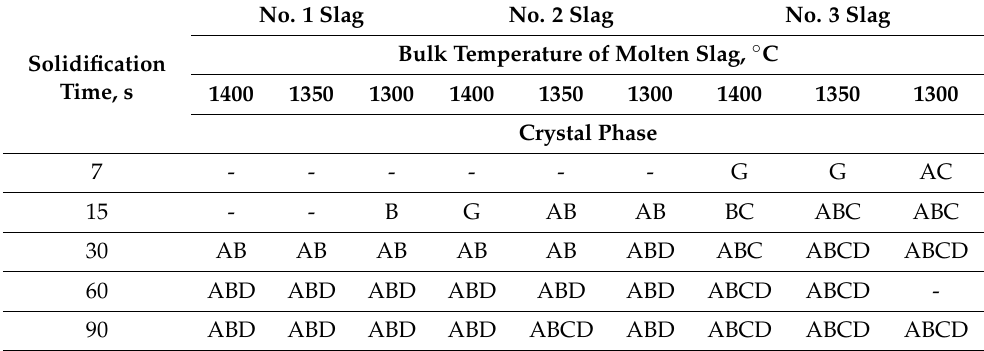
Table 3. Major crystal phases in films with different solidification times and slag bulk temperatures.